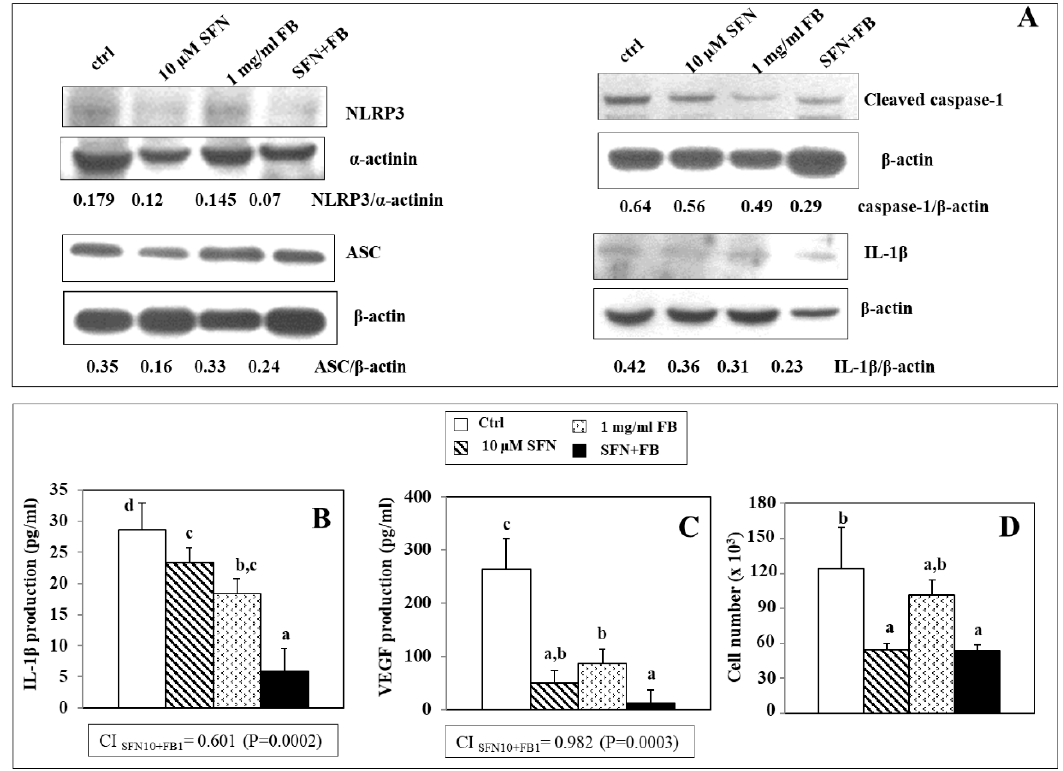
Figure 5. Effect of a combination of SFN (10 μ M) and FB (1 mg/mL) on the expression of NLRP3, Figure 5. E ff ect of a combination of SFN (10 µ M) and FB (1 mg / mL) on the expression of NLRP3,